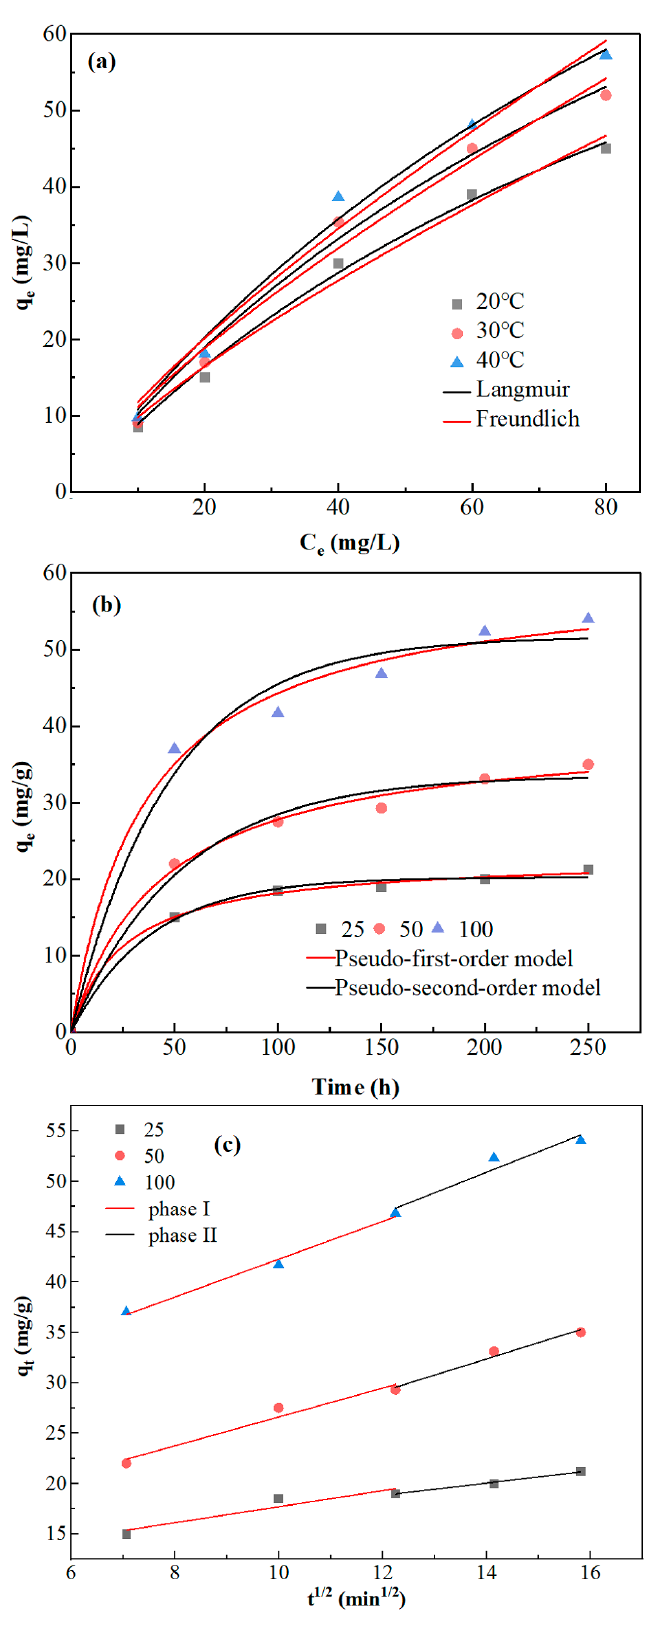
Figure 4. ( a ) Adsorption isotherm study for Aspergillus niger . ( b ) Kinetic analysis for Aspergillus niger . ( c ) The intra-particle diffusion model of Aspergillus niger . Table 5. Fitting constant values of intra-particle diffusion model.